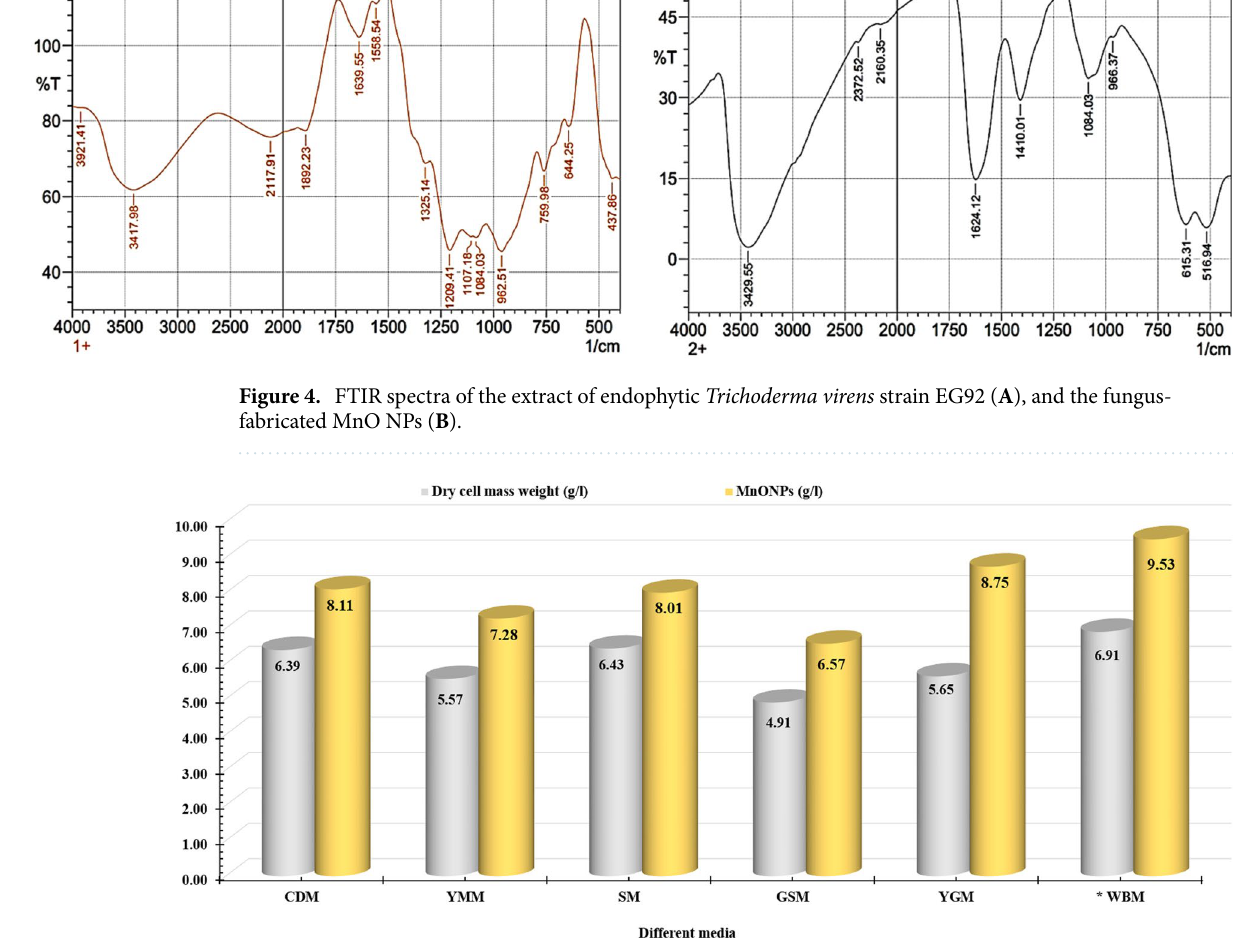
Figure 5. Different media that selected for cultivation of endophytic Trichoderma virens strain EG92 to fabricate MnO NPs. Czapek-Dox medium (CDM), Yeast Malt medium (YMM), Synthetic medium(SM),